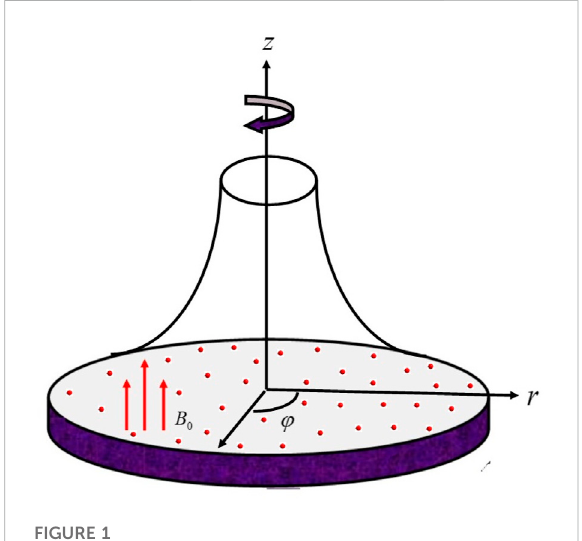
FIGURE 1 Ternary hybrid nano fl uid fl ow over a rotating